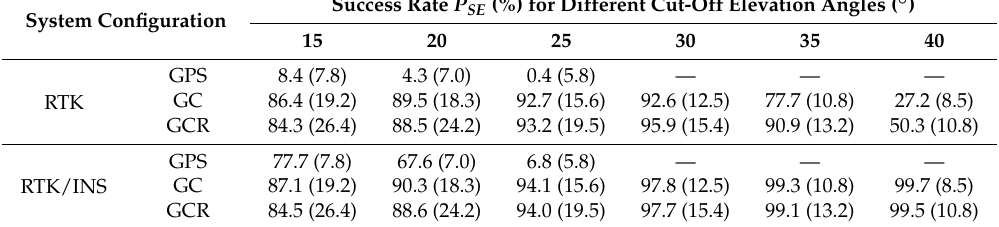
Table 3. Single-frequency, single-epoch AR empirical success rate for different system configurations with elevation cut-off angles of 15, 20, 25, 30, 35 and 40°. The RMSs of the corresponding number of satellites are shown within parentheses.